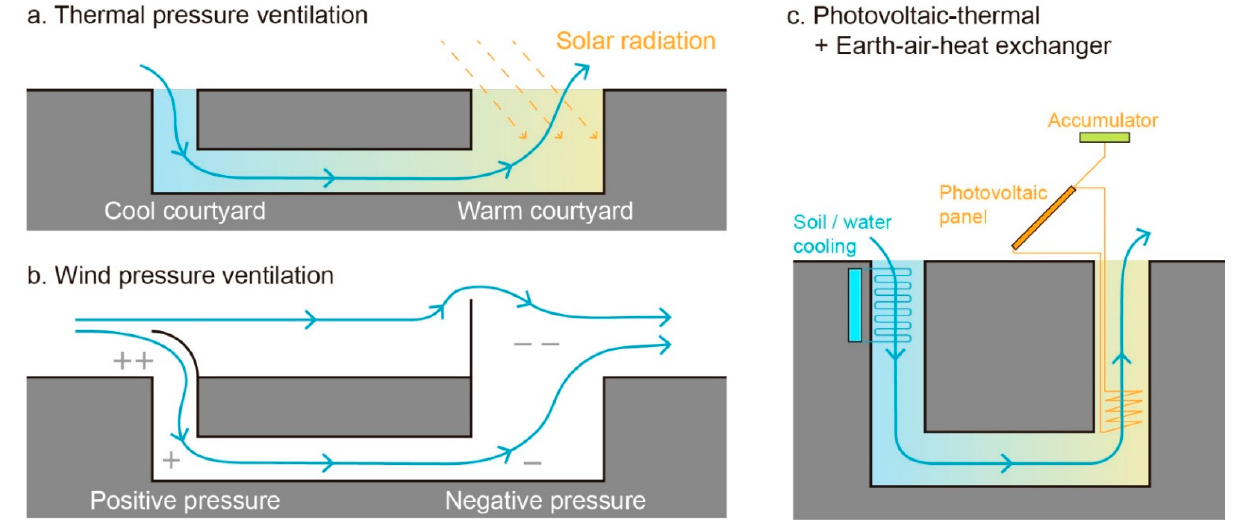
Figure 10. Active and passive techniques for natural ventilation in underground spaces.